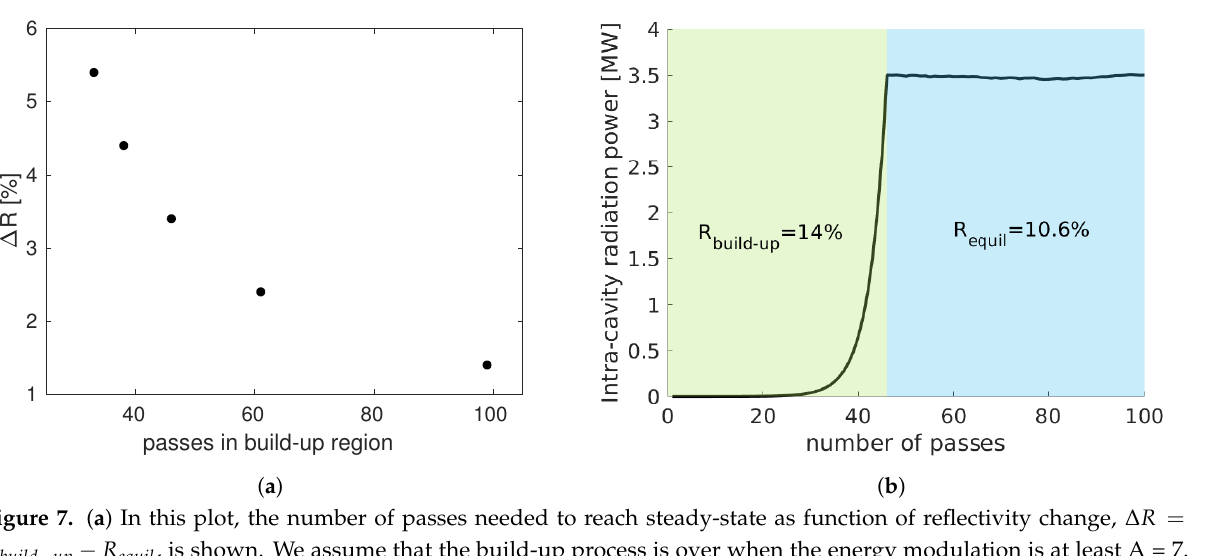
= 14% and from the 47th pass onward up −